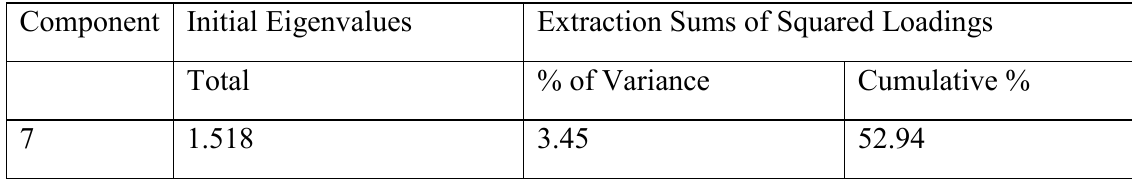
Table 1.13: Variance explained for Absorptive Resilience PC7 Component